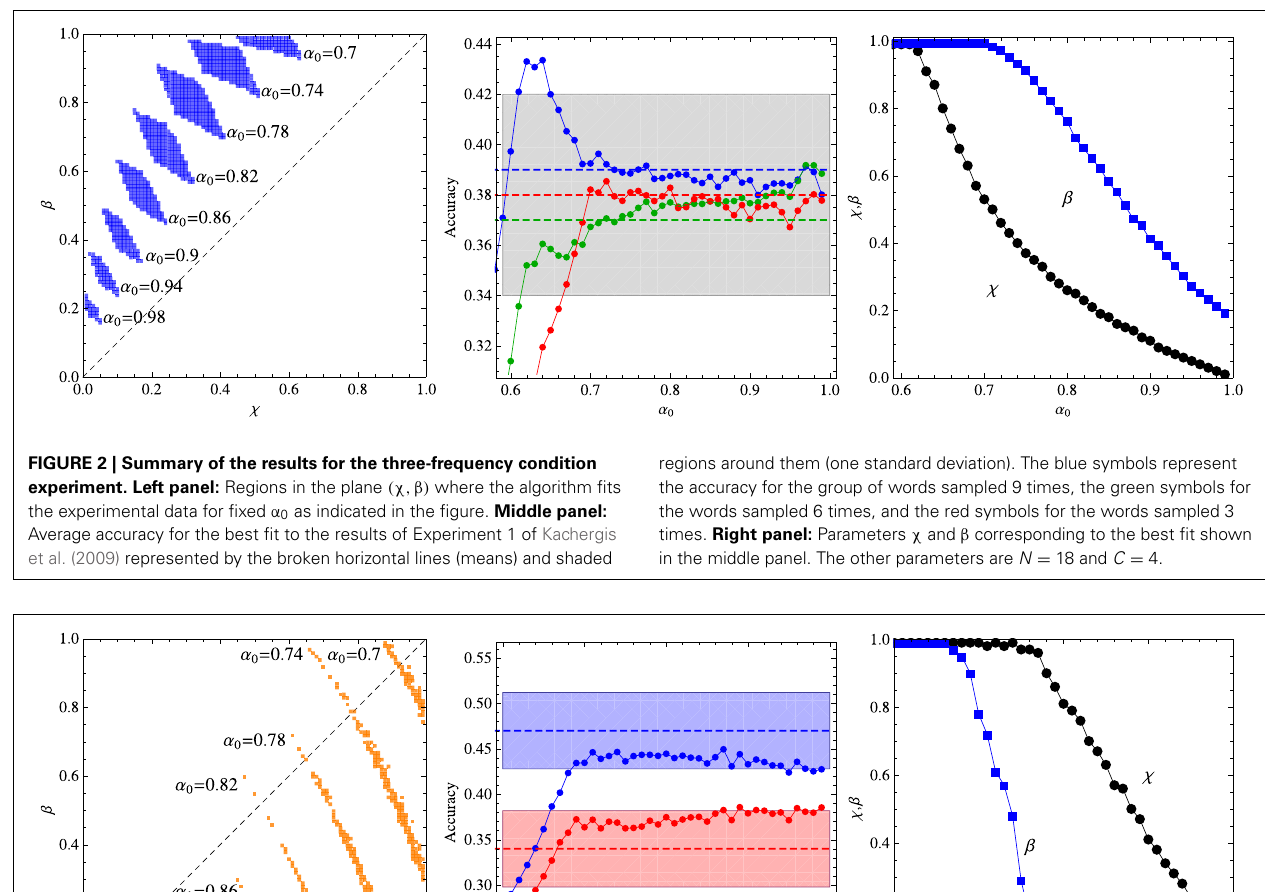
FIGURE 3 | Summary of the results of the two-level contextual diversity experiment. Left panel: Regions in the plane ( χ , β ) where the algorithm fits the experimental data for fixed α 0 as indicated in the figure. Middle panel: Average accuracy for the best fit to the results of Experiment 2 of Kachergis et al. (2009) represented by the broken horizontal lines (means) and shaded regions around them (one standard